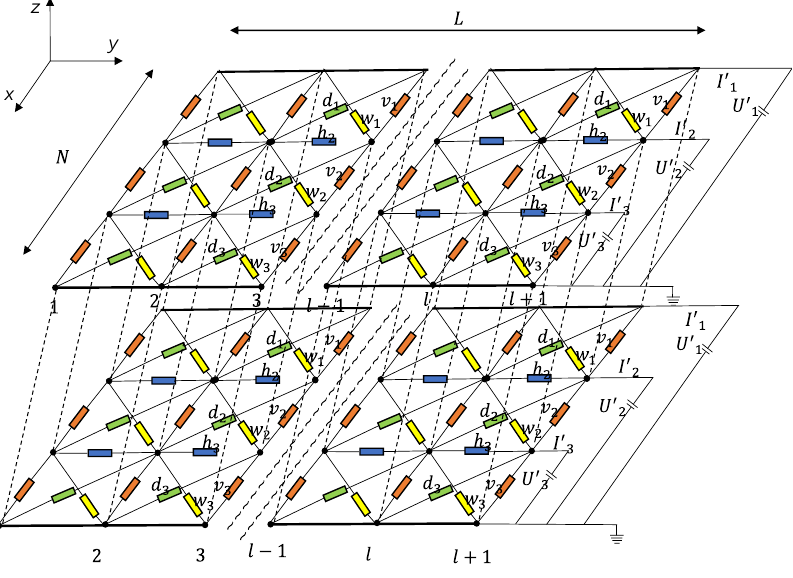
Figure 5. Three − dimensional infinite circuit network.